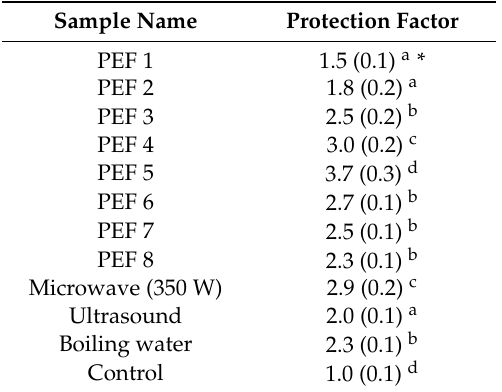
Table 5. Antioxidant activity (Protection Factor—Rancimat method) of the